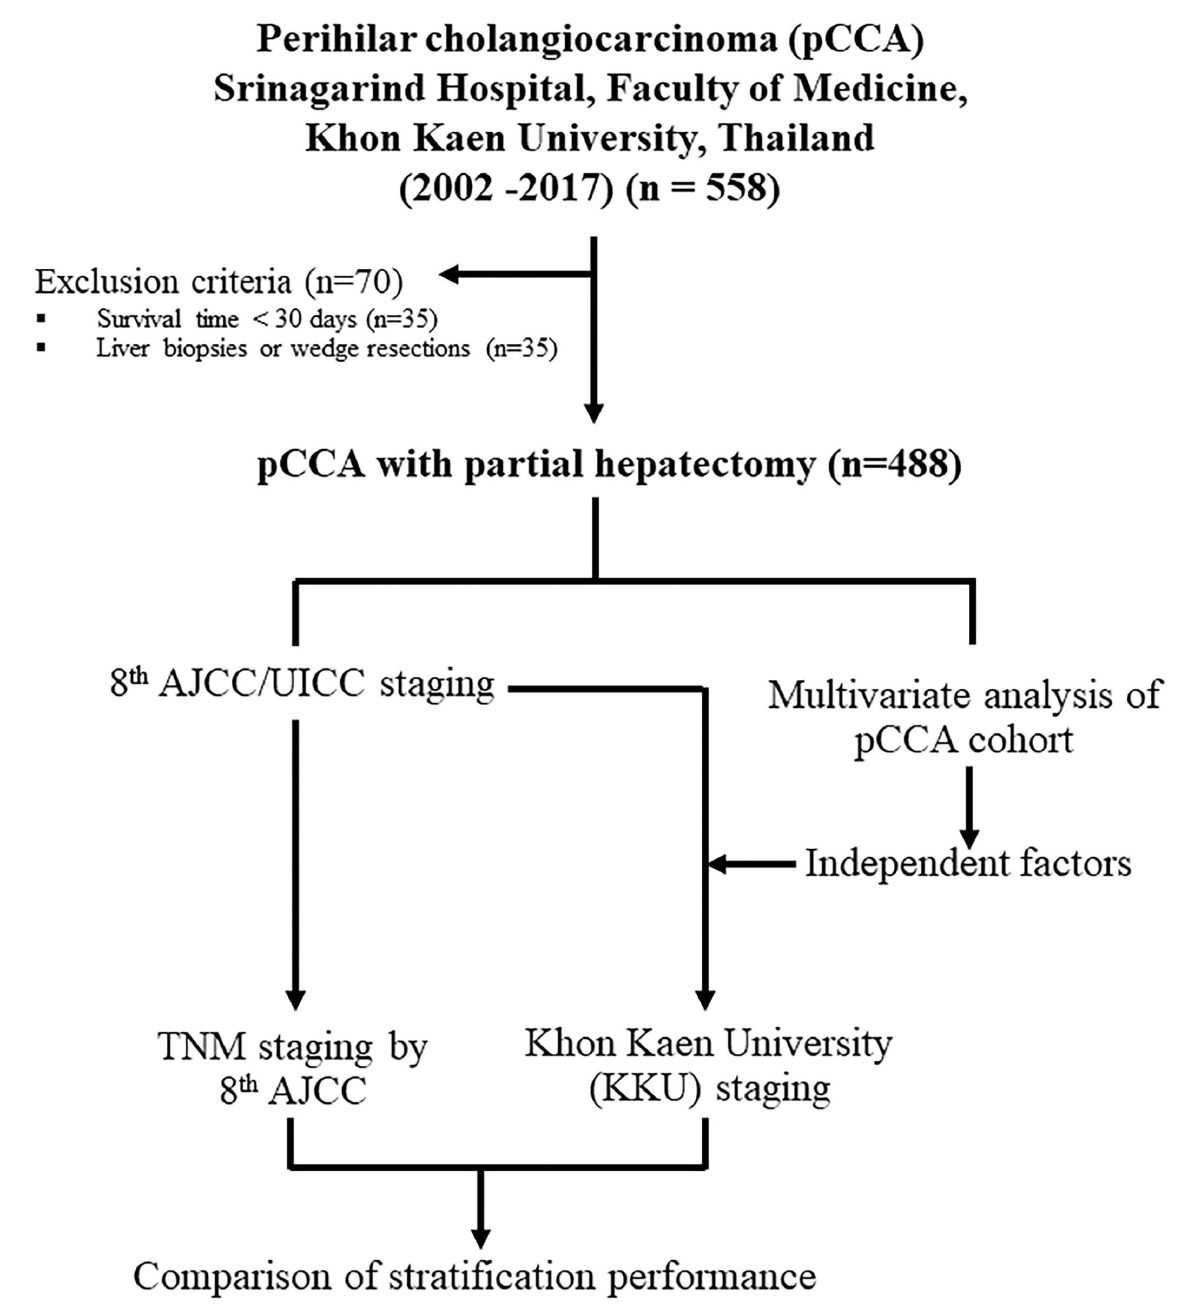
FIGURE1 Schematic design for this study on the modification of the eighth edition AJCC/UICC staging system to the Khon Kaen University (KKU) staging system for the prognostic stratification and management of patients with perihilar cholangiocarcinoma in Northeast